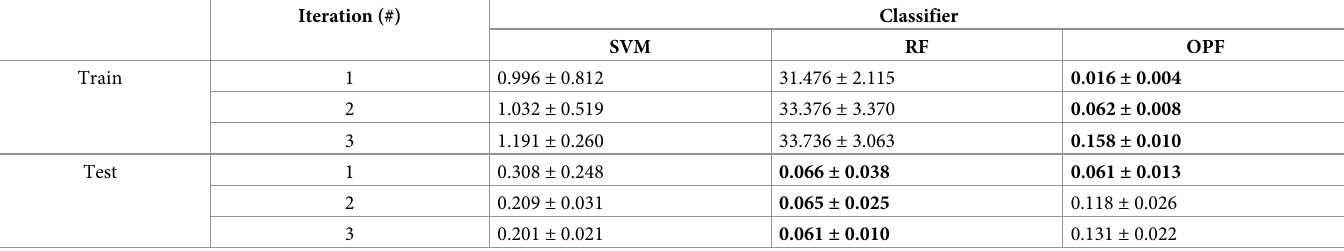
Table 2. Average computational times and standard deviations (in milliseconds) per iteration for the training and testing processes, using the supervised classifiers for the ALL-AML dataset. The best results (shorter times) are highlighted in bold.